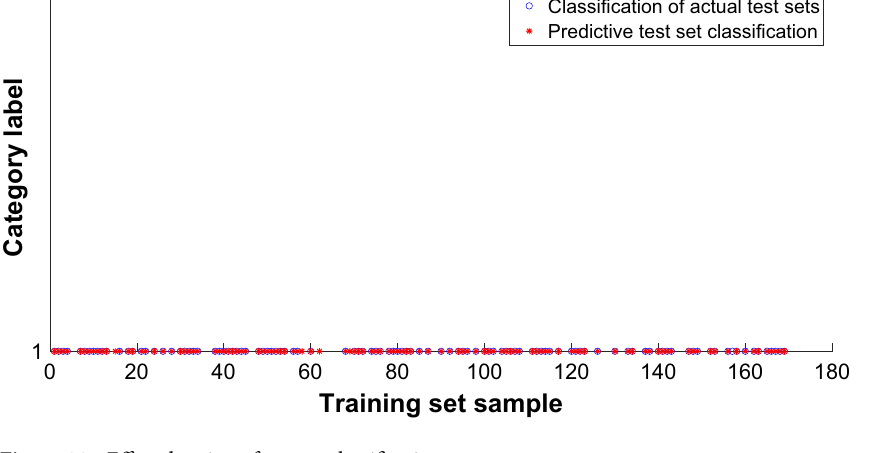
Figure 11. Effect drawing of test set